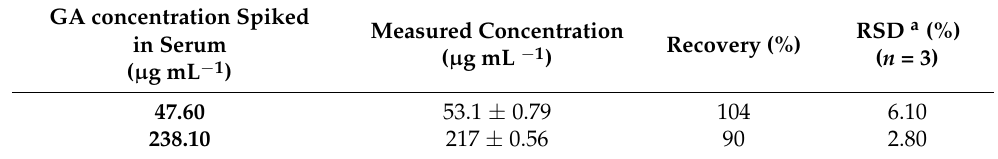
Table 4. Recovery assay of GA in human serum using the developed aptasensor. GA concentration